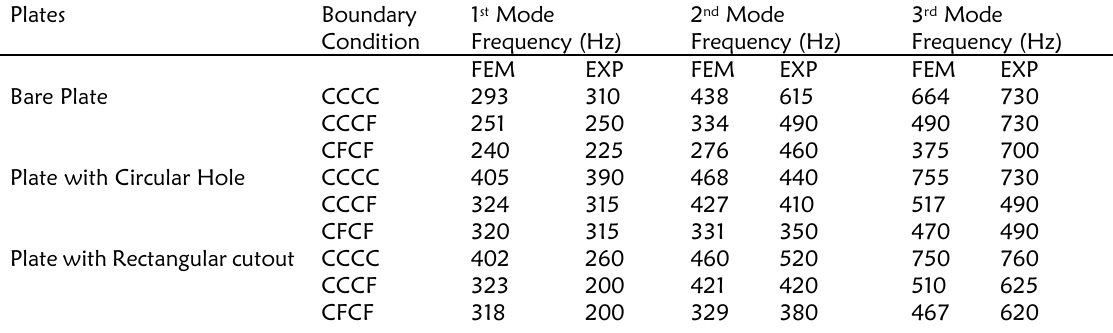
Table 2: Comparison of natural frequencies from experiment and FEM